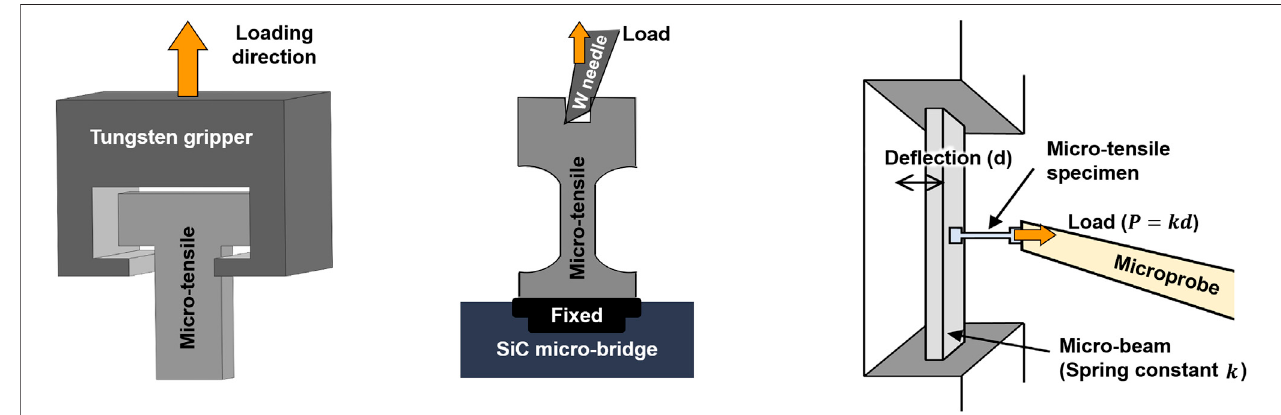
FIGURE 7 | Schematic drawings of the various micro-tensile test setups. Reproduced from Yu et al. (2022) and Miura et al. (2018), under the Creative Commons CC-BY-NC-ND license.